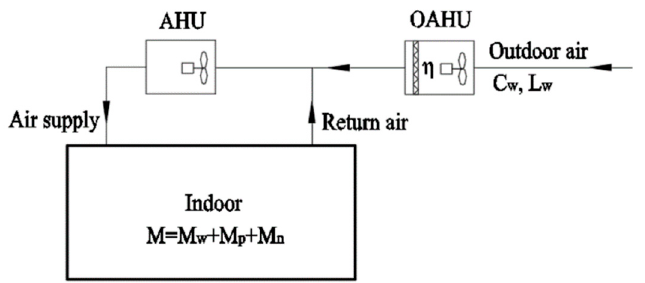
Figure 6. Schematic diagram of a centralized system with outdoor air pretreatment and purifying